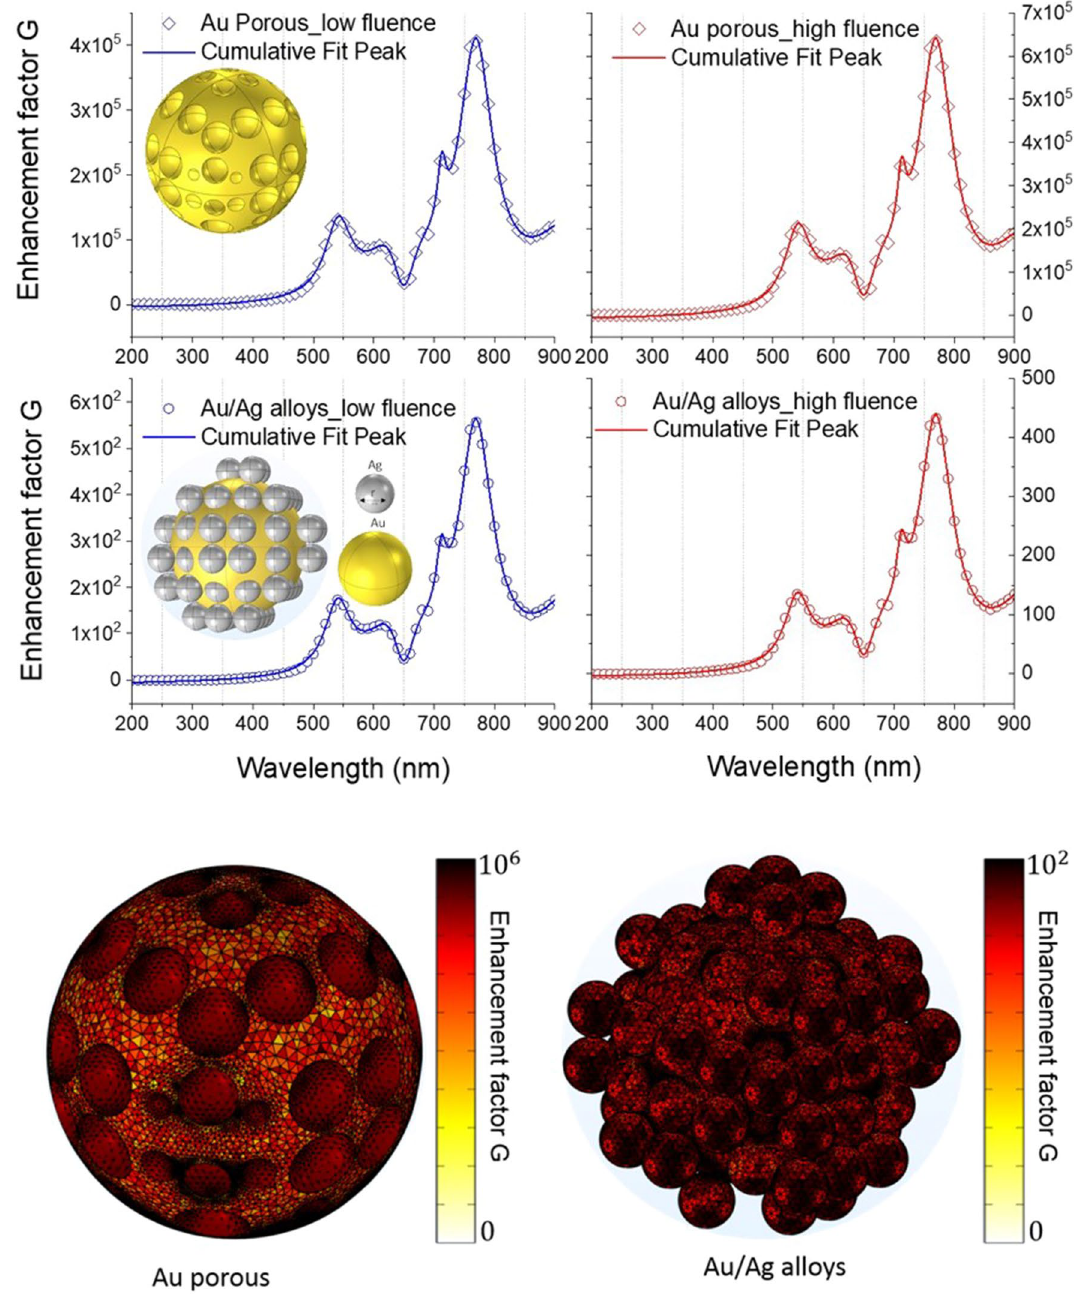
Figure 8. Up: enhancement factor G in Au/Ag alloys and porous Au for low and high laser fluence. Down: simulations of electromagnetic field enhancement presenting the localization of hot spot on the porous gold nanoparticles and in Au/Ag